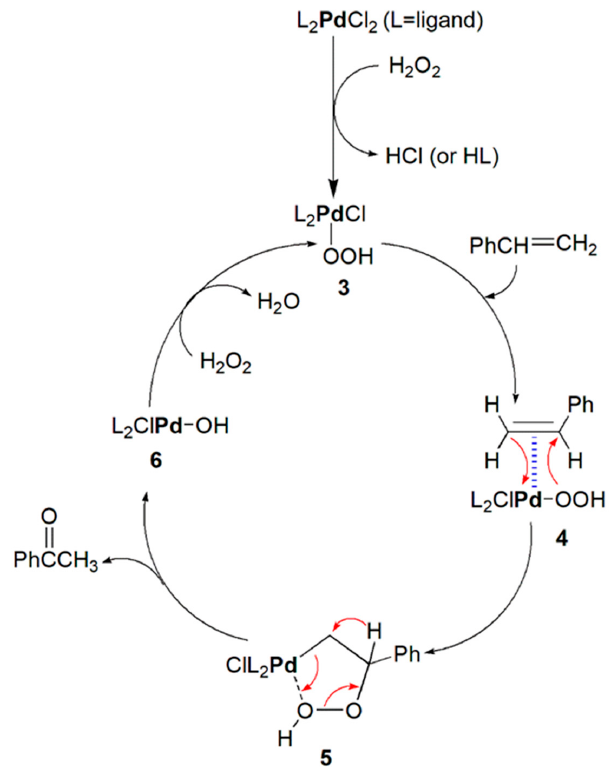
Figure 5. Postulated mechanism for the oxidation styrene to acetophenone.